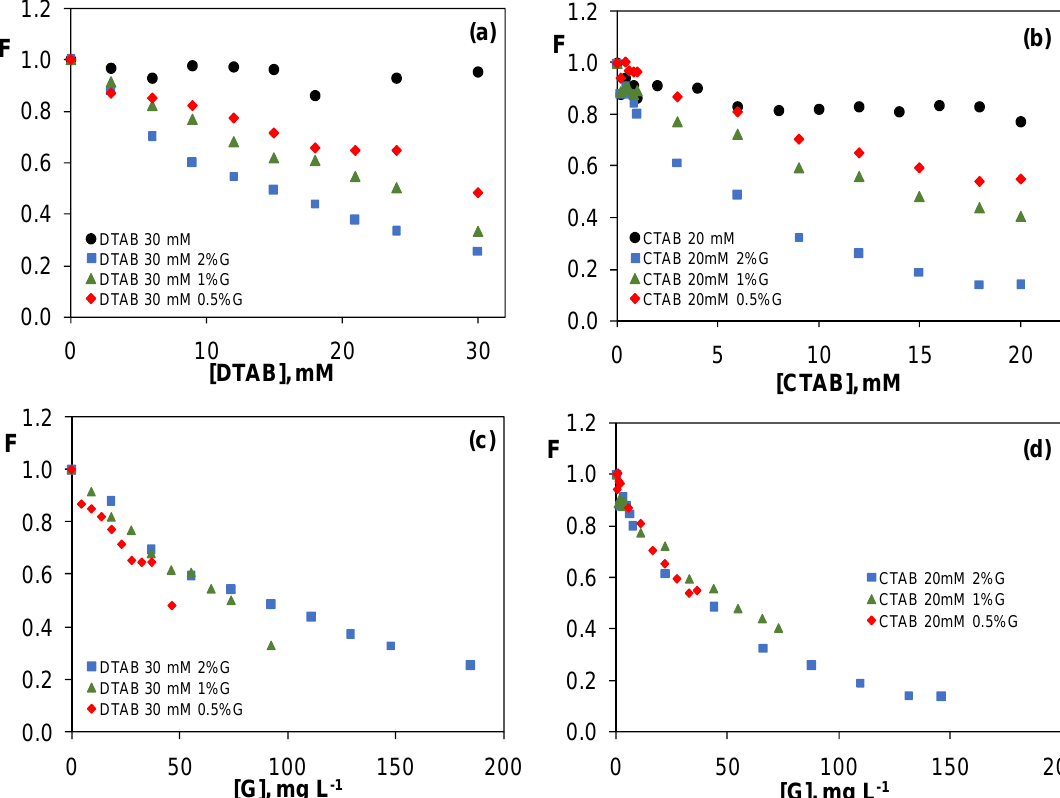
Figure 7. F ( λ exc = 325 nm; λ em = 395 nm) vs. surfactant ( a , b ) or graphene ( c , d ) concentration for G dispersions in 30 mM DTAB ( a , c ) and 20 mM CTAB ( b , d ) with a constant G/surfactant weight ratio.